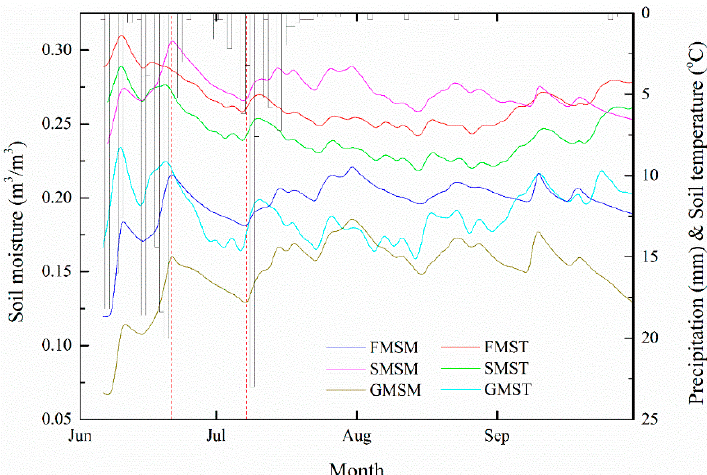
Figure 2. Dynamics of the mean soil moisture, soil temperature, and precipitation profiles during June and September (FMSM—spruce forest mean soil moisture, SMSM—shrubland mean soil moisture, GMSM—grassland mean soil moisture, FMST—spruce forest mean soil temperature, SMST—shrubland mean soil temperature, and GMST—grassland mean soil temperature). The area between the two red dotted lines was chosen to calculate water loss.